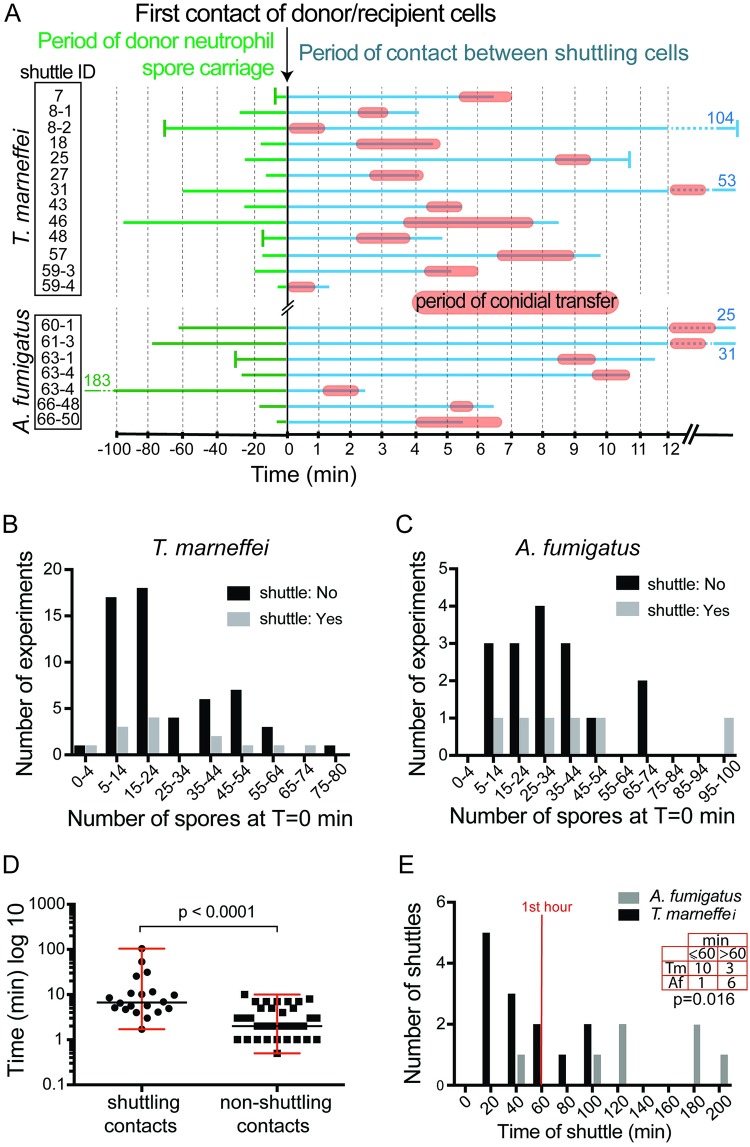
Dynamics of neutrophil-to-macrophage conidial shuttles.(A) Time maps of cellular contact during shuttles. Charts are aligned with t = 0 at the point of initial donor–recipient cell contact. Chart shows time of conidial residence in donor neutrophil prior to intercellular contact (green line; vertical bar indicates resident at start of imaging; otherwise, line start indicates point of neutrophil phagocytosis), time of general intercellular contact (blue line), and period of contact during actual conidial transfer (orange bars). Charts are for each of 20 stringently defined unequivocal shuttles (n = 13 T. marneffei, n = 7 A. fumigatus) tabulated and identified as in S1 Fig. The entire sequence from phagocytosis to cell separation is shown unless vertical bars at beginning or end of lines indicate the start or end of the imaging file; blue and green numbers indicate endpoint times where lines have been clipped. (B,C) For T. marneffei (B) and A. fumigatus (C) infections, histograms of number of experiments with and without observed shuttles are shown by number of conidia present in the initial imaging volume. (D) For conidia-laden neutrophils, duration of shuttling contacts (n = 20 shuttles) compared to random nonshuttling contact (n = 34) is shown. Data are summarized by median and range. (E) Distribution of times of shuttle after imaging commenced for T. marneffei and A. fumigatus. p = 0.016 for categorical variable of shuttles occurring at ≤60 and >60 min between the two fungal species (Fisher’s exact test). Datasets for A–E are provided in S1 Data.